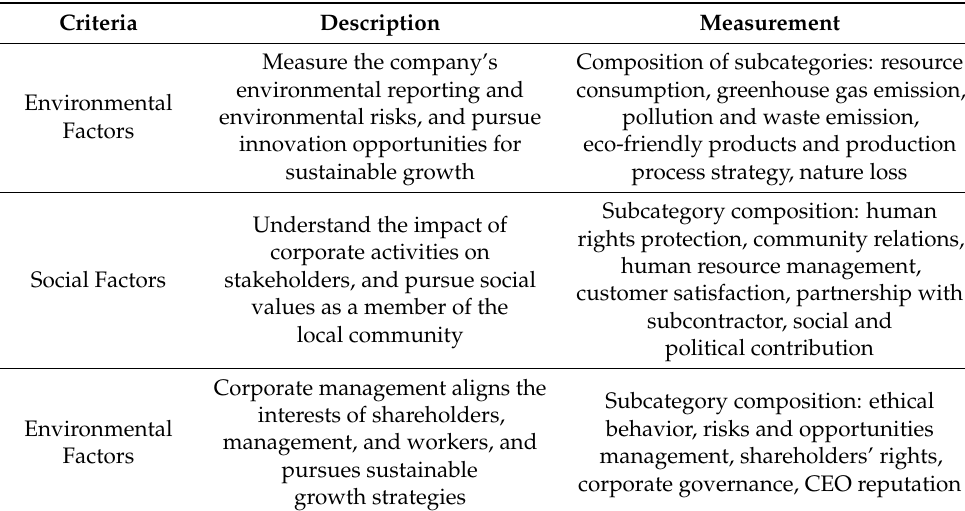
Table A3. Main criteria: definitions and descriptions of key